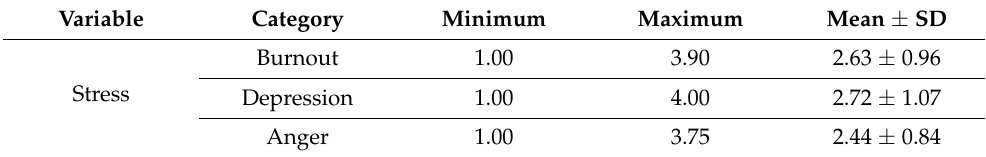
Table 4. Descriptive statistical analysis of stress. Variable Category Minimum Stress